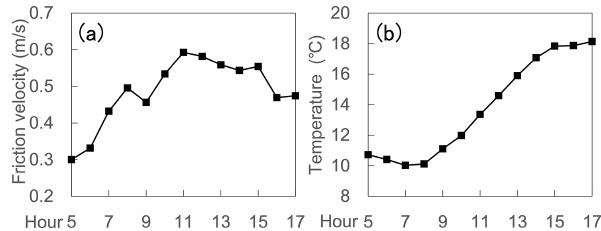
Figure 2. Time variations of hourly (a) friction velocity and (b) temperature for inflow.